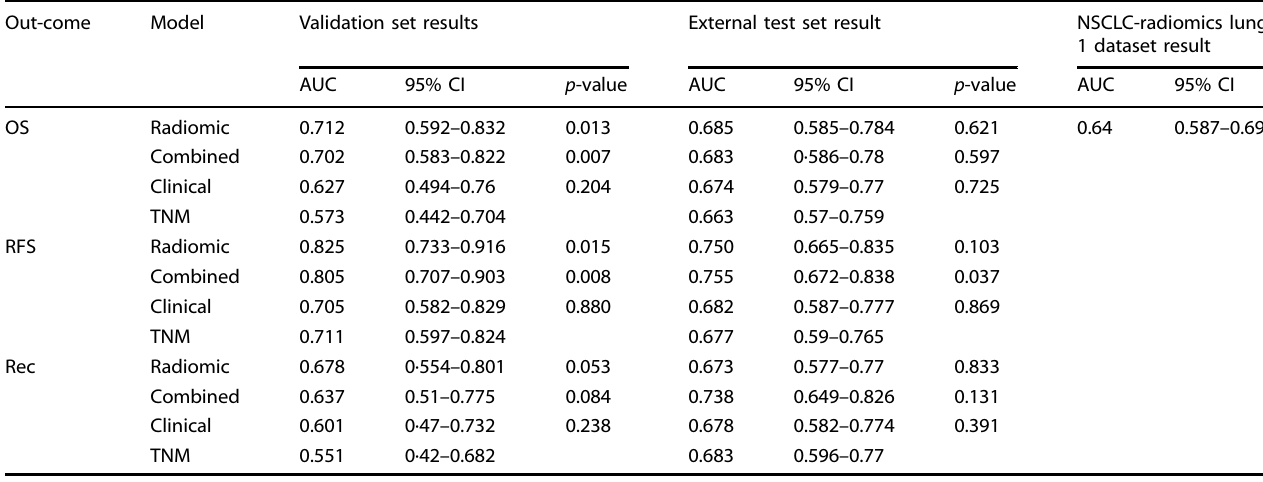
Table 2. AUC with 95% con fi dence intervals for the validation and external test set(s) for each prediction model, benchmarked against a model based on